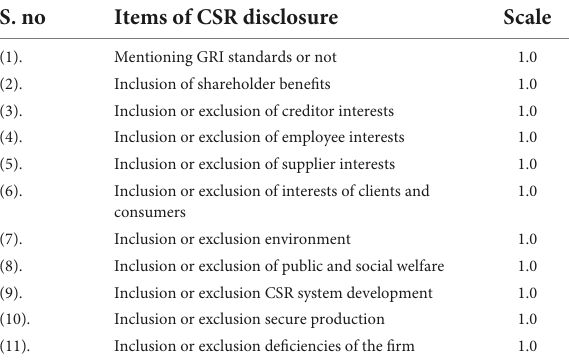
TABLE 1 Index of corporate social responsibility